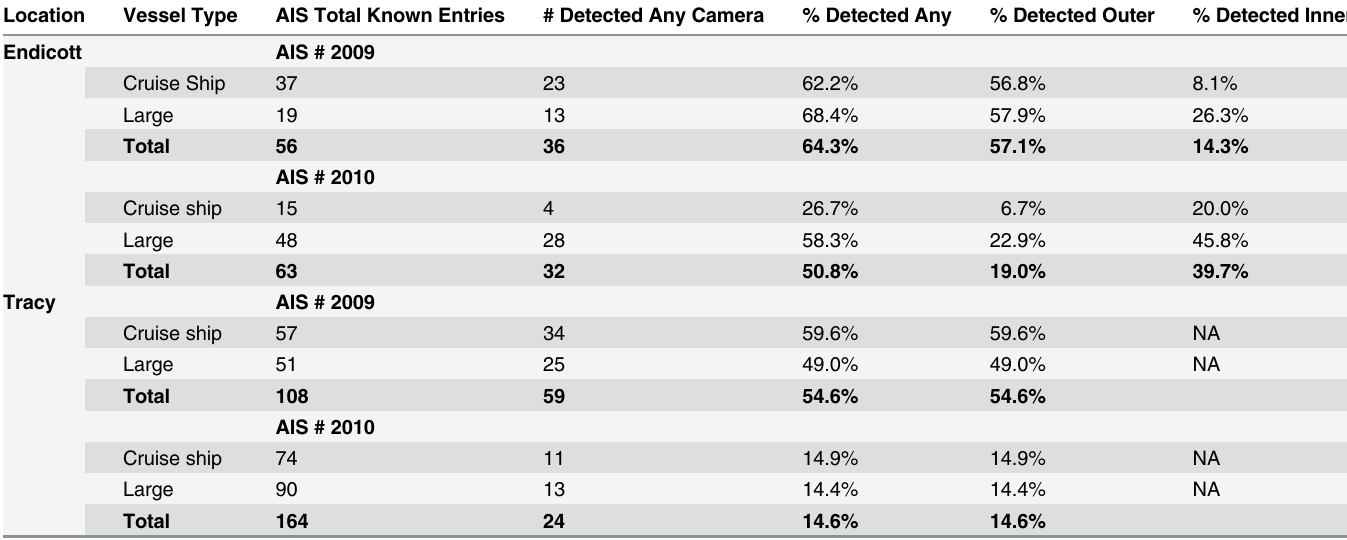
Comparison of numbers and percentage of AIS-equipped vessels known to be entering Endicott and Tracy Arms, according to AIS data, compared to numbers detected at each camera site in 2009 and 2010 in each